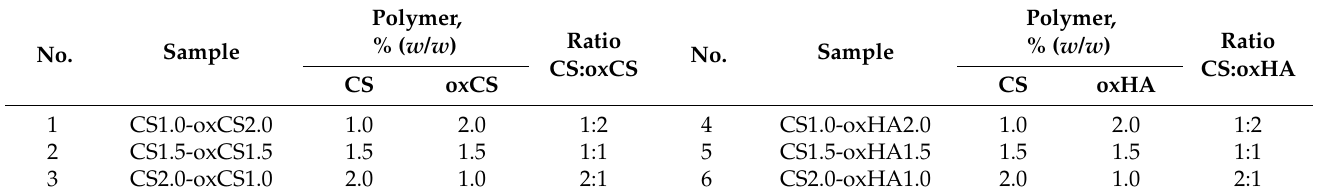
Table 1. The composition of CS-oxCS/oxHA